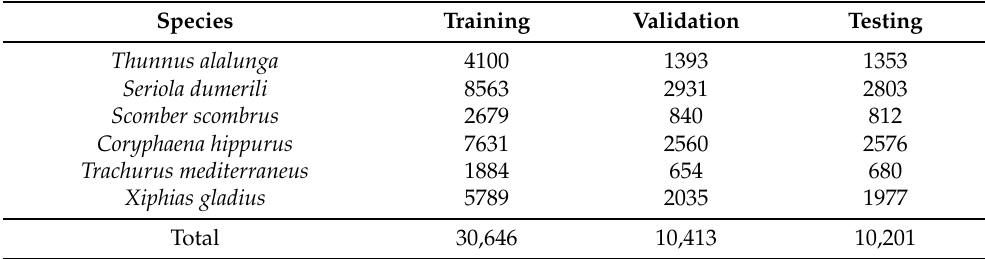
Table 2. Distribution of images subsets for training. Total number of images: 51,260. The worst-case imbalance is almost 8:1 between Seriola dumerili and Trachurus mediterraneus . Species Training Validation Testing Thunnus alalunga